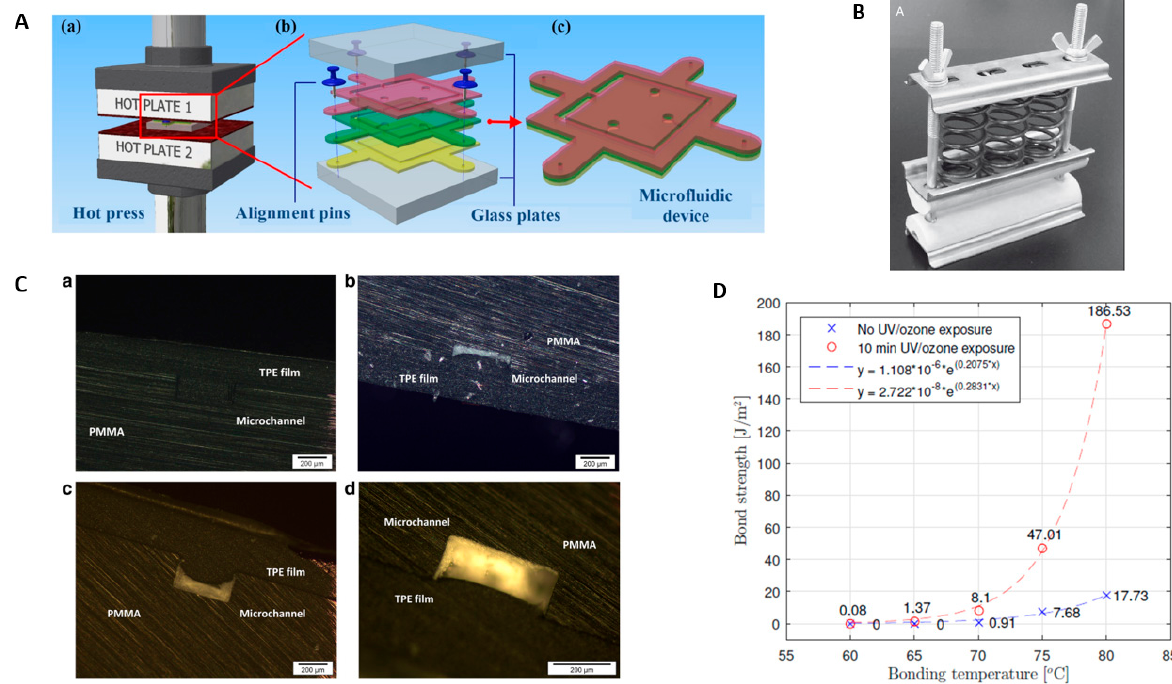
Figure 2. ( A ) Schematic of the thermal fusion bonding process. Reprinted with permission from ref.